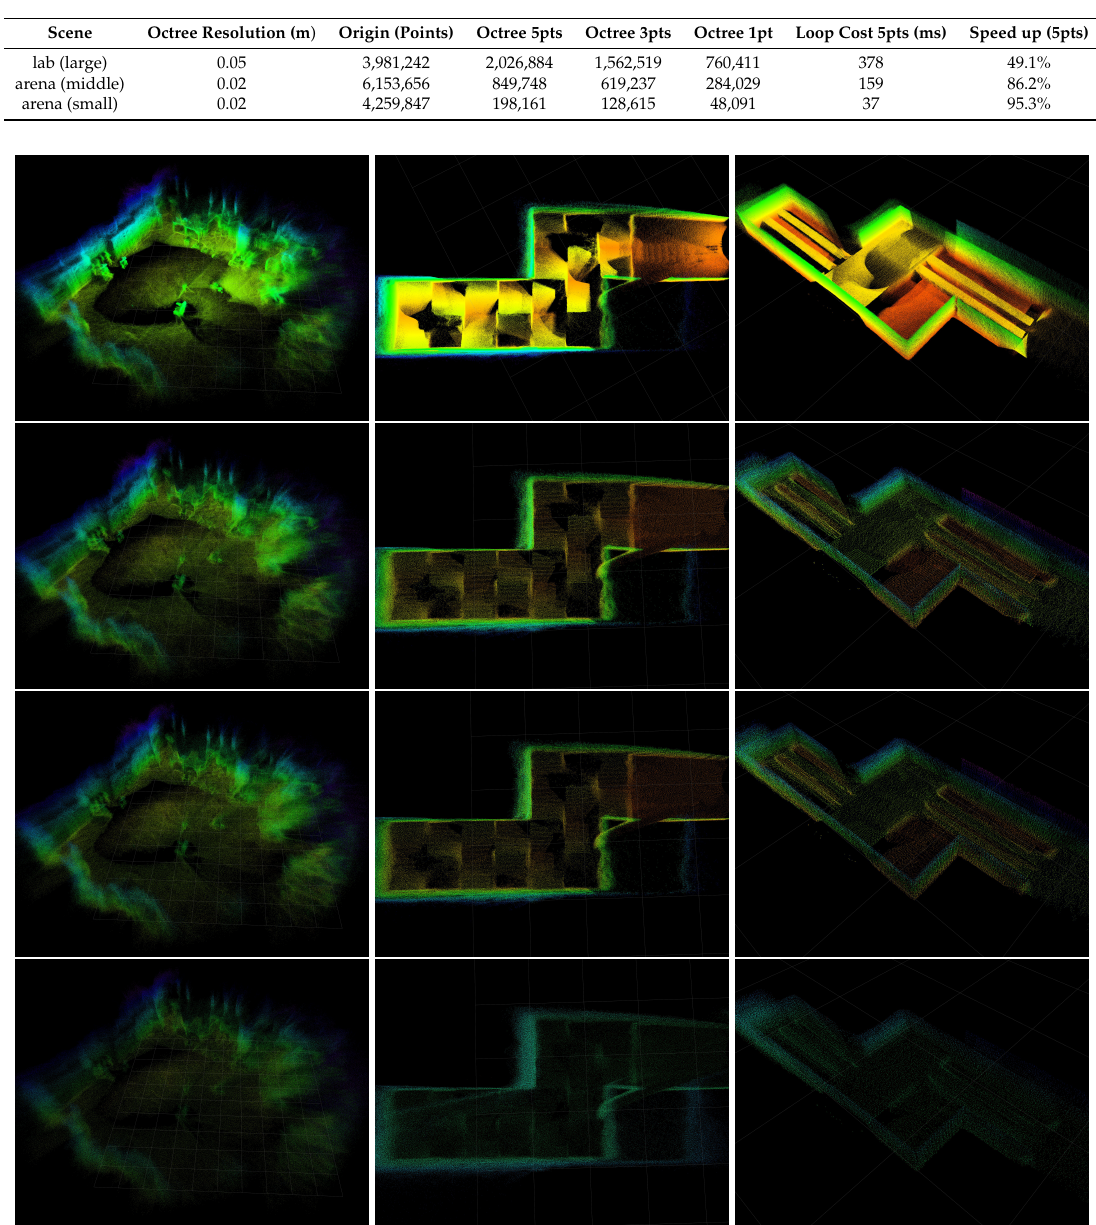
Figure 21. Mapping result corresponding to comparison in Table 2, from left to right: lab (large), arena (middle), arena